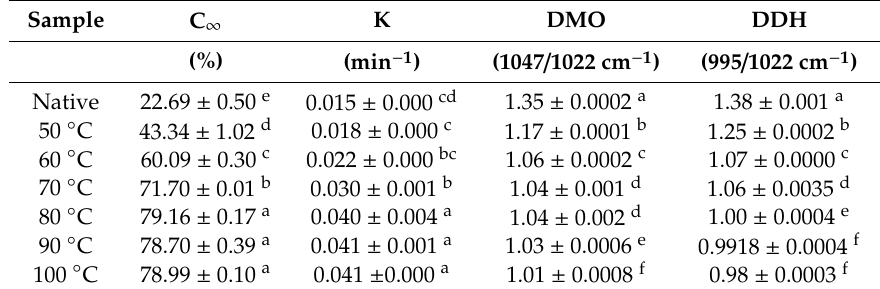
Table 3. Digestion and FTIR properties of controlled gelatinized mung bean